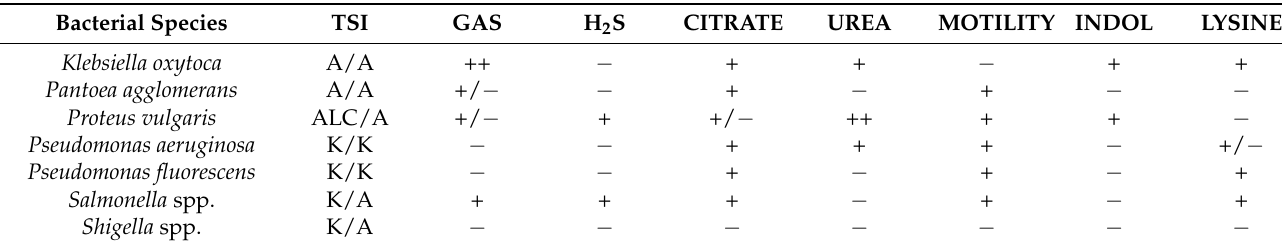
The references are show in methodology. Abbreviations and symbols: alkaline reaction (K), alkaline (ALC), acid (A), hydrogen sulfide (H